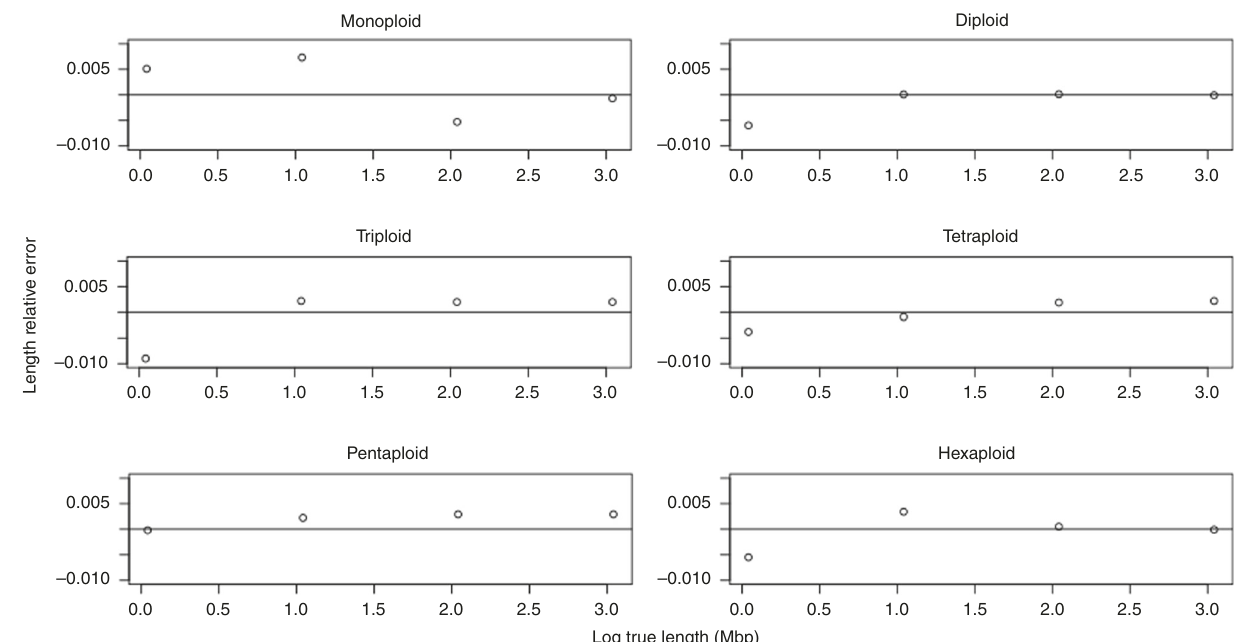
Fig. 5 Length parameter sweep. Results shown for monoploid, diploid, triploid, tetraploid, pentaploid, and hexaploid simulated datasets.